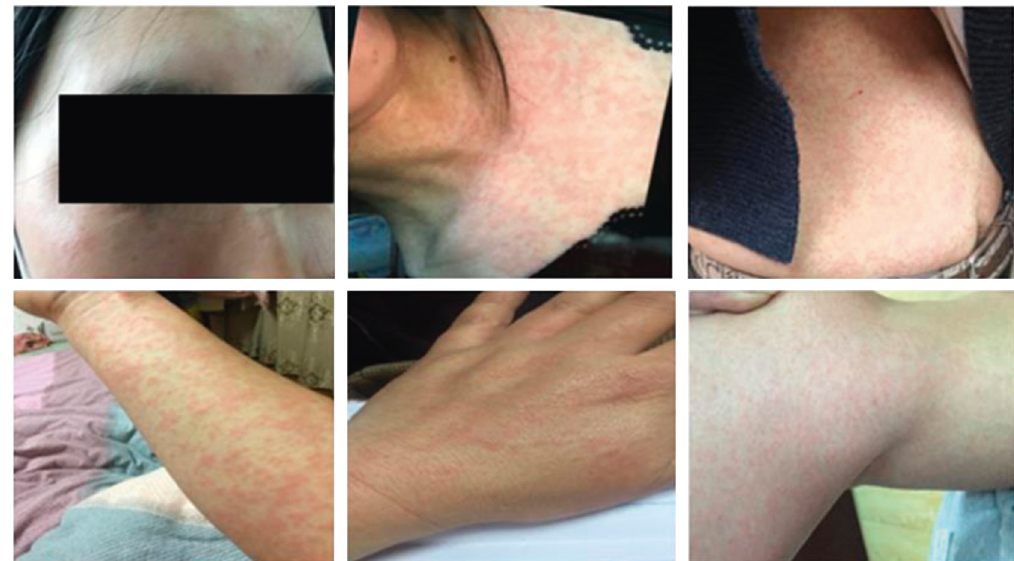
Figure 3: Typical clinical symptoms of the patients.